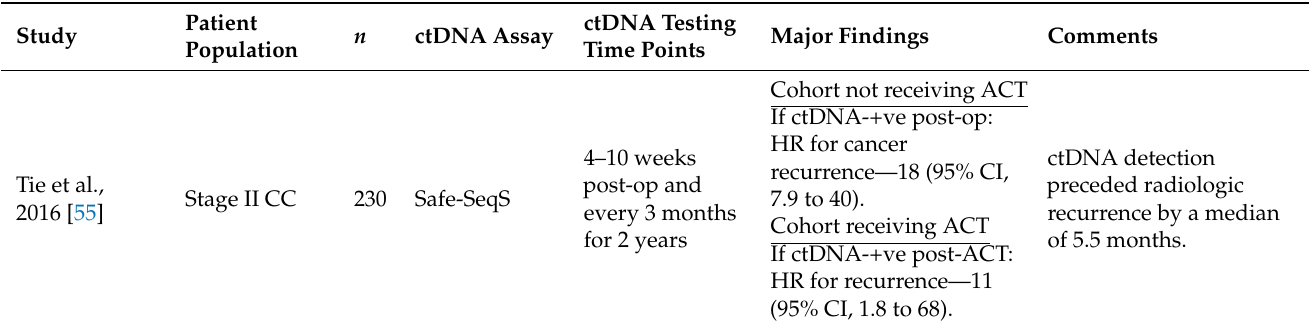
Table 2. Selected studies supporting the value of circulating tumor DNA (ctDNA) for minimal residual disease assessment and surveillance in patients with resected